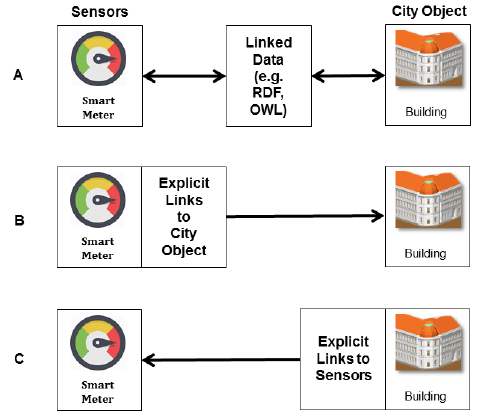
Figure 1. Possibile ways for linking Sensors with City